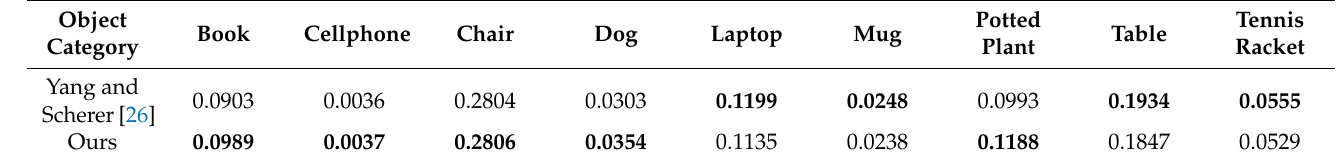
Table 4. The 3D-IoU results for generated cuboid by [26] and our approach.